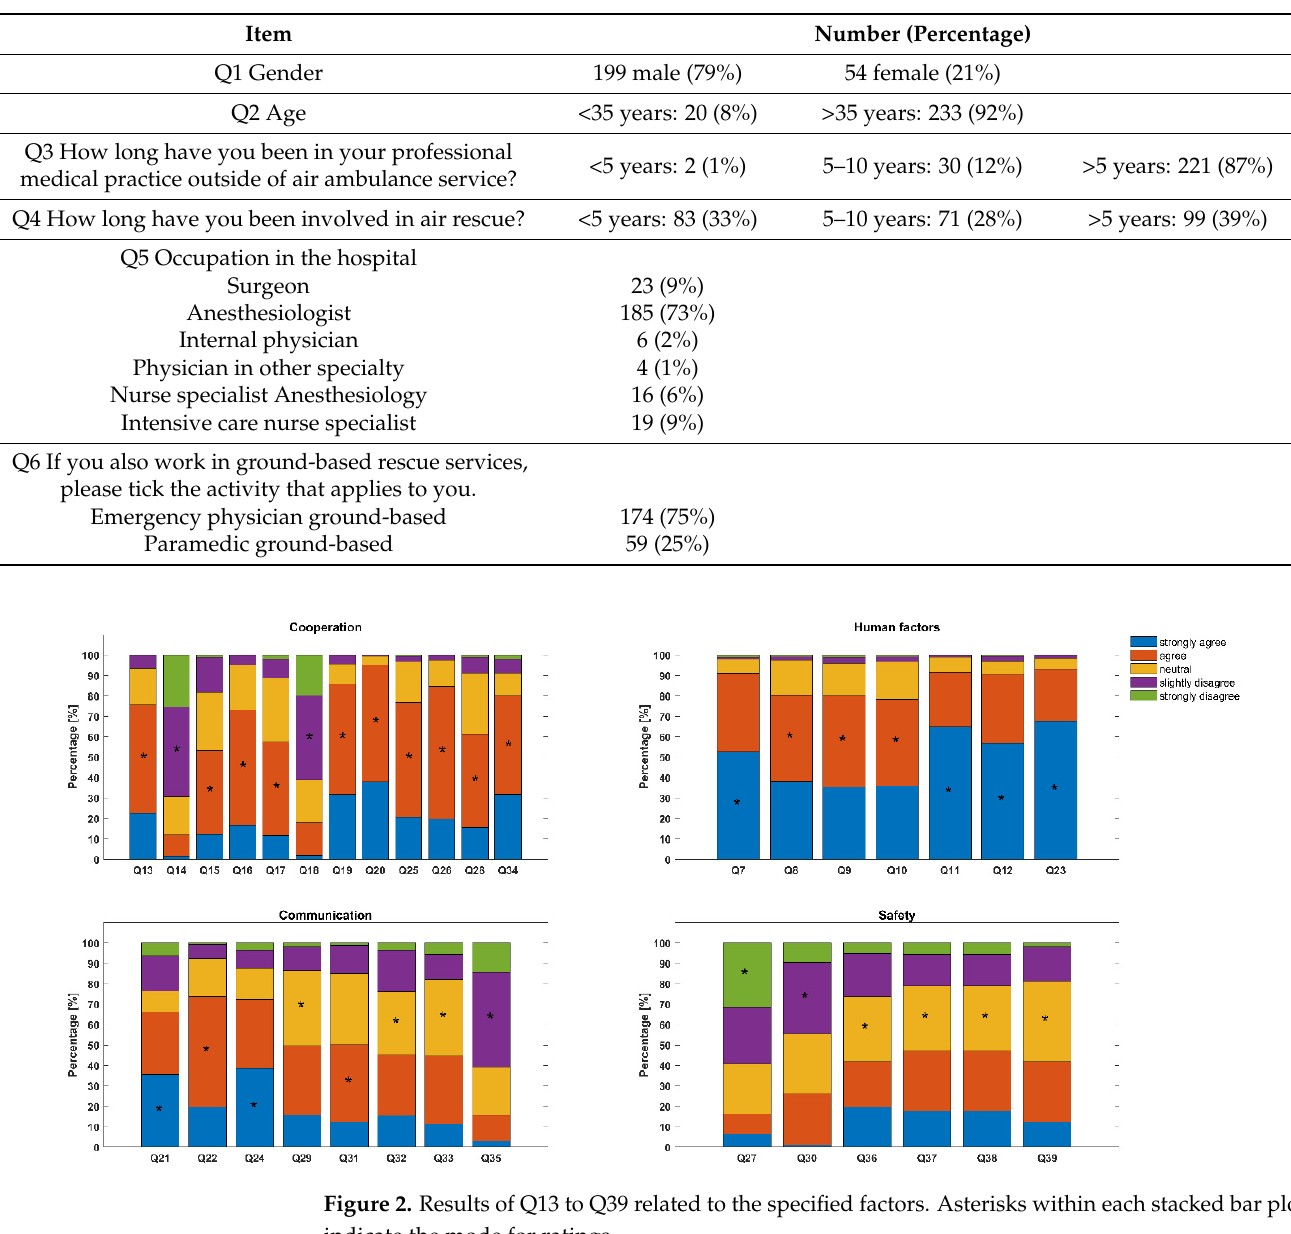
Table 3. Results of items Q1 to Q6 (respondents’ general data) with row percentage in brackets.